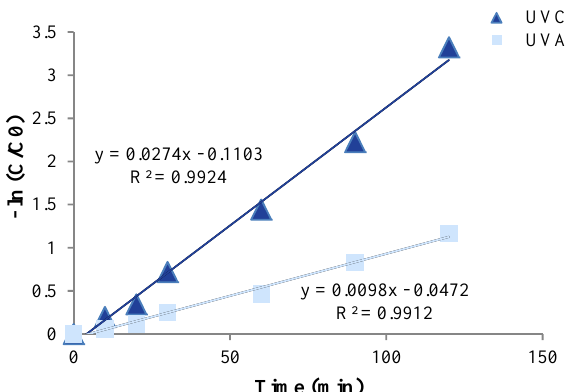
Figure 4. Effect of the type of UV light on decolorization efficiency (%) [Methylene blue (MB) concentration = 5 mg/l, reaction time = 120 min, and pH =